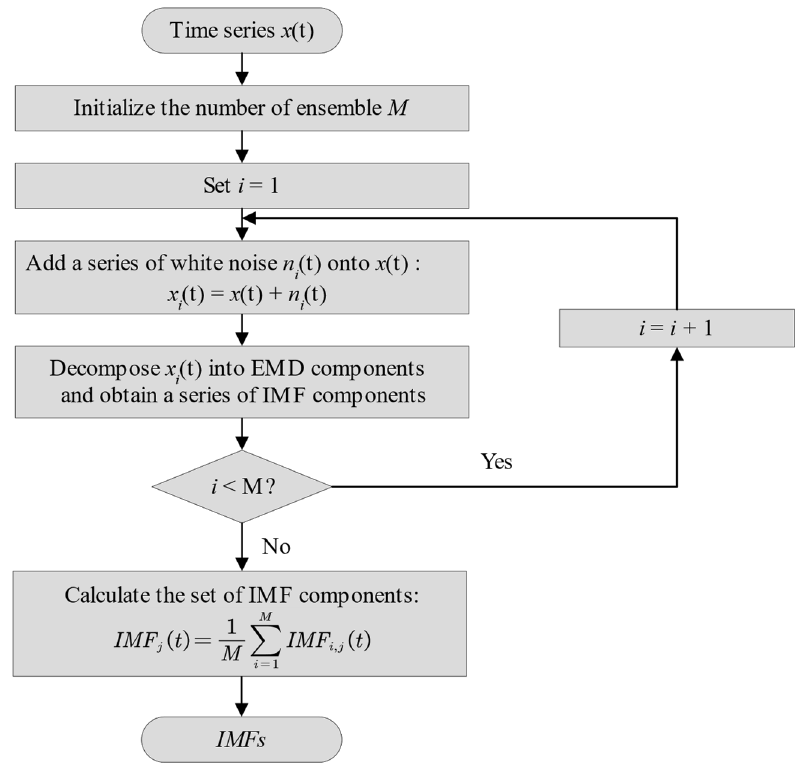
Figure 2. Flow chart of the EEMD method.